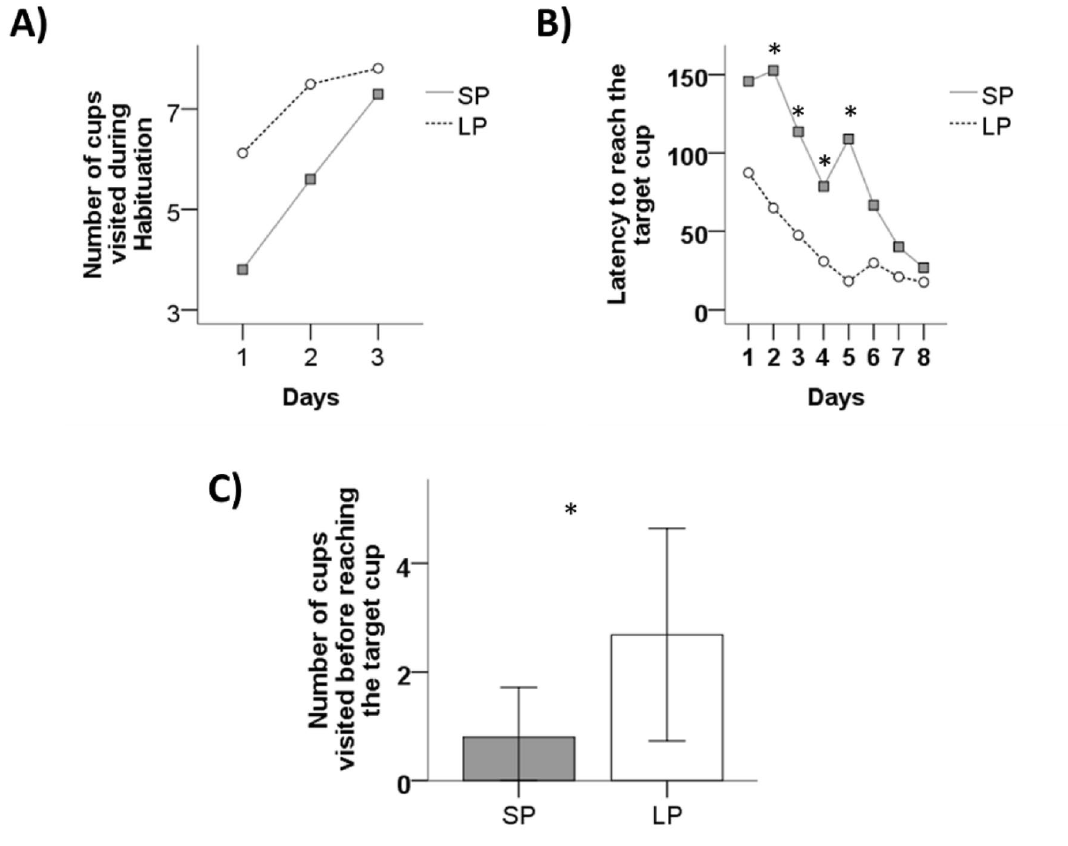
Figure 4. Effects of photoperiod on spatial orientation performances. ( A ) Number of visited cups over days of habituation for quail exposed to short (SP) and long (LP) photoperiod. ( B ) Latency to visit the location of the target cup (in seconds) over training days for SP and LP birds. ( C ) Number of cups visited before reaching the target cup during the probe trial for SP and LP birds. * p < 0.05. Data are presented as estimated marginal means ( A ). Data are presented as mean ± S.D. ( B , C